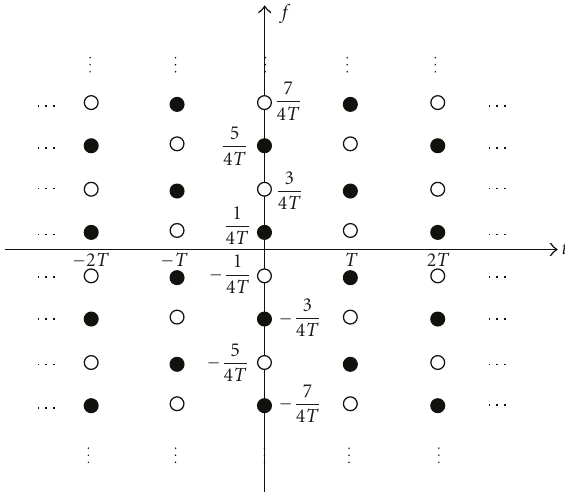
Figure 11: Time-frequency phase space for transmission in